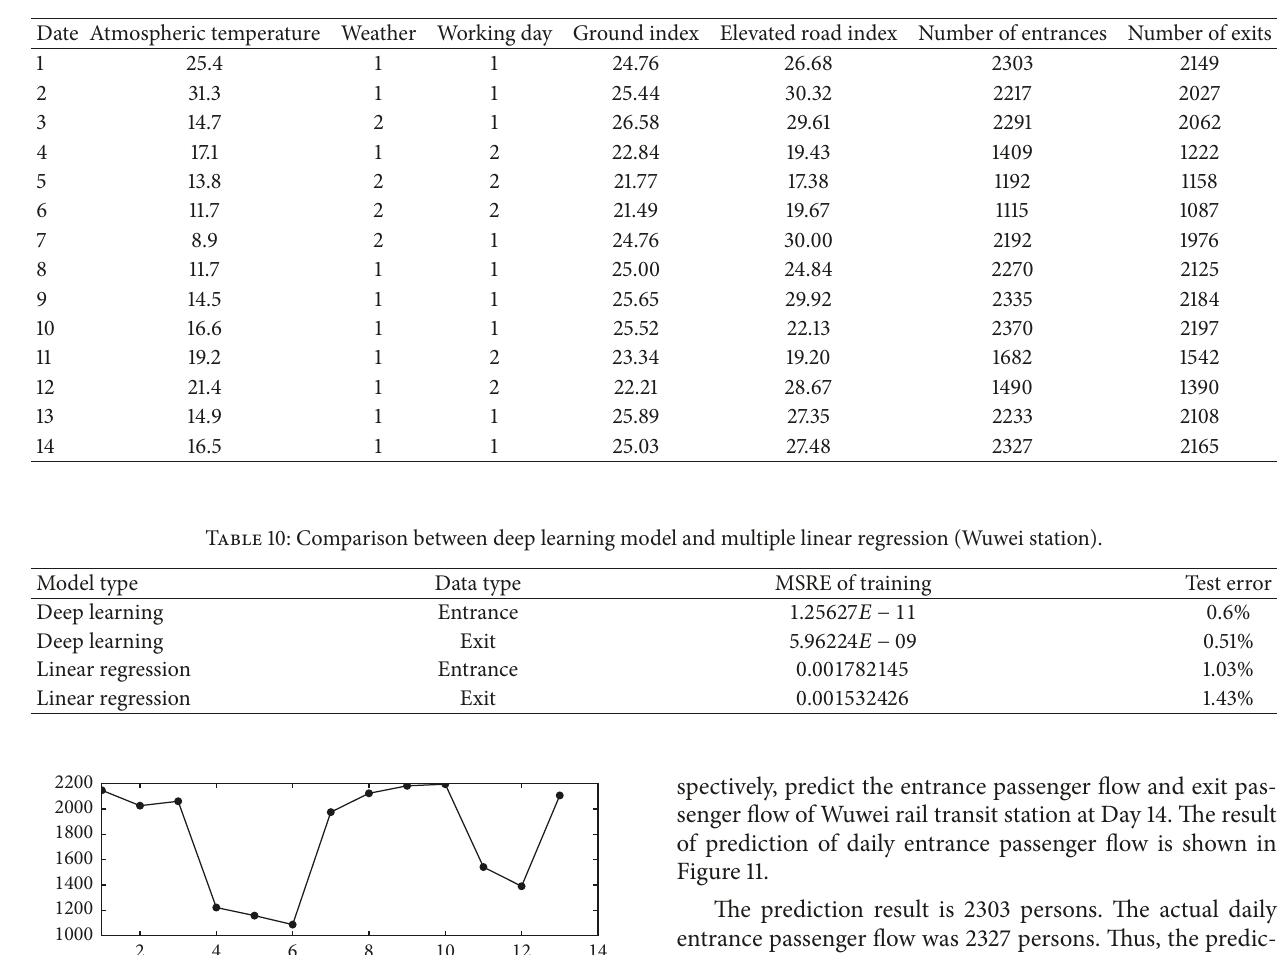
Table 9: Relevant data of passenger flow of Wuwei rail transit station.